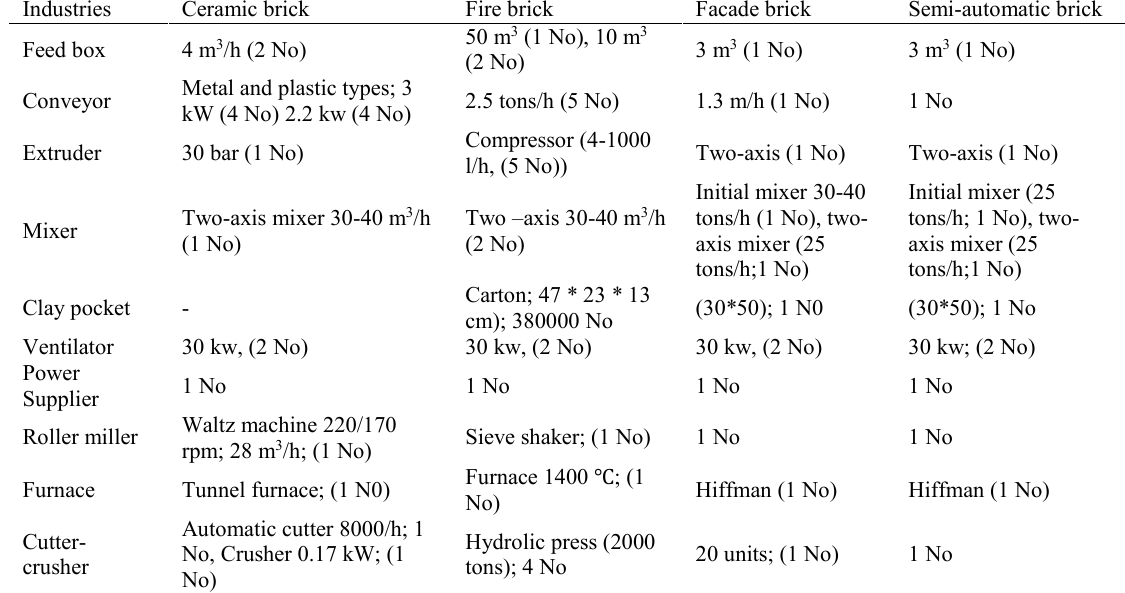
Fig. 1. Diagram of Ceramic brick, firebrick, facade and semi-automatic bricks manufacturing respectively (This study) Table 1. Requirements of FMBMI (This study)